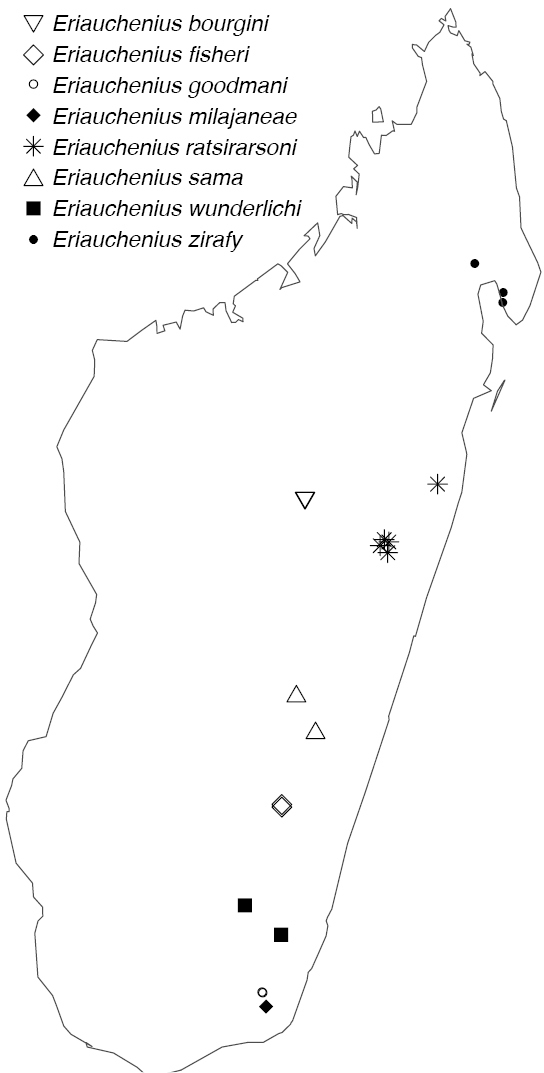
Distribution map for Eriauchenius species.